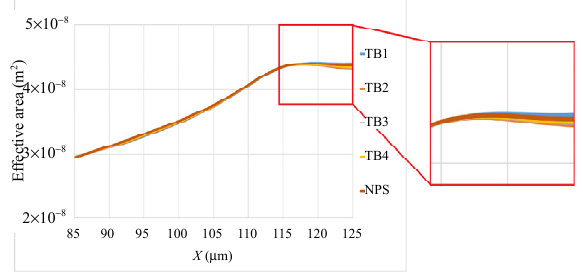
Fig. 9 A eff of the proposed sensor for various tuberculosis-infected samples versus X at 2.2 THz.